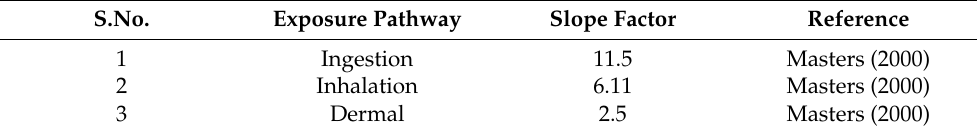
Table 4. Slope factor (mg kg − 1 d − 1 ) − 1 of benz[a]pyrene for different exposure pathways.